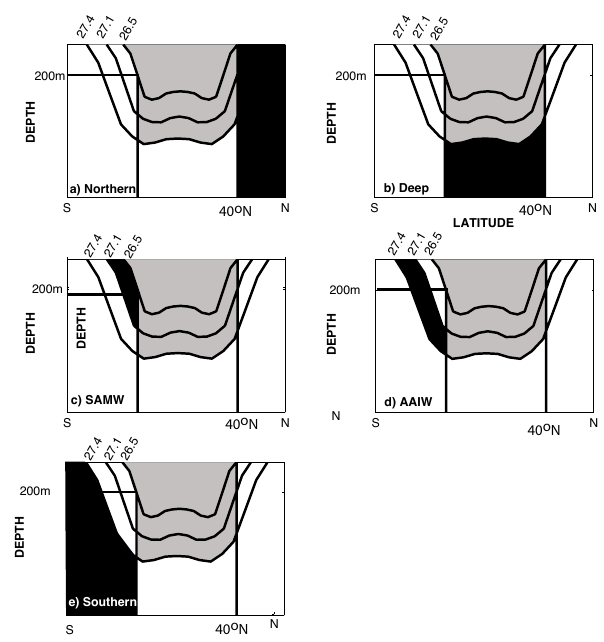
Fig. 4. A schematic of the experimental design used to examine the nutrient return pathways to the low latitude surface ocean. Each panel represents the deployment of a regional tag in zonal cross- section. The curvy lines represent selected isopycnals, as labeled at the top of each panel. In the black area, the dye tag, phosphate, and DOP are tagged according to the following conventions: (a) The Northern tag (which was further subdivided into North Atlantic and North Pacific) set on all water north of 40 ◦ N. (b) The Deep Low latitude tag, set for all water with potential densities greater than 27.4 between 40 ◦ N and a southern boundary defined by the latitude where the 26.5 isopycnal intersects 200m. (c) The SAMW tag, set between that same boundary and the 27.1 isopycnal. (d) AAIW tag, set between the 27.1 and 27.4 isopycnals southward of the same boundary. (e) Southern tag for all water denser than AAIW and southward of the boundary. In the white areas, the tag is destroyed and set to its new region. In the gray areas, all tags behave according to their conservation